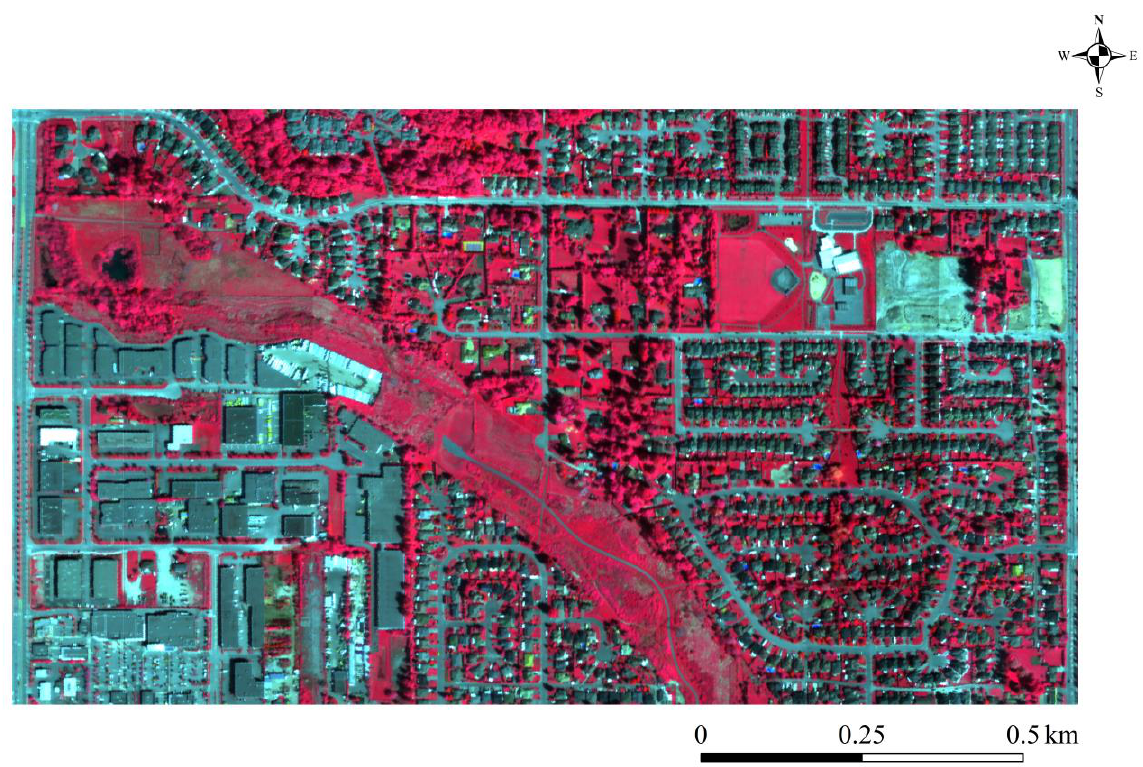
Figure 2. The hyperspectral image of the Surrey dataset in false-color display.